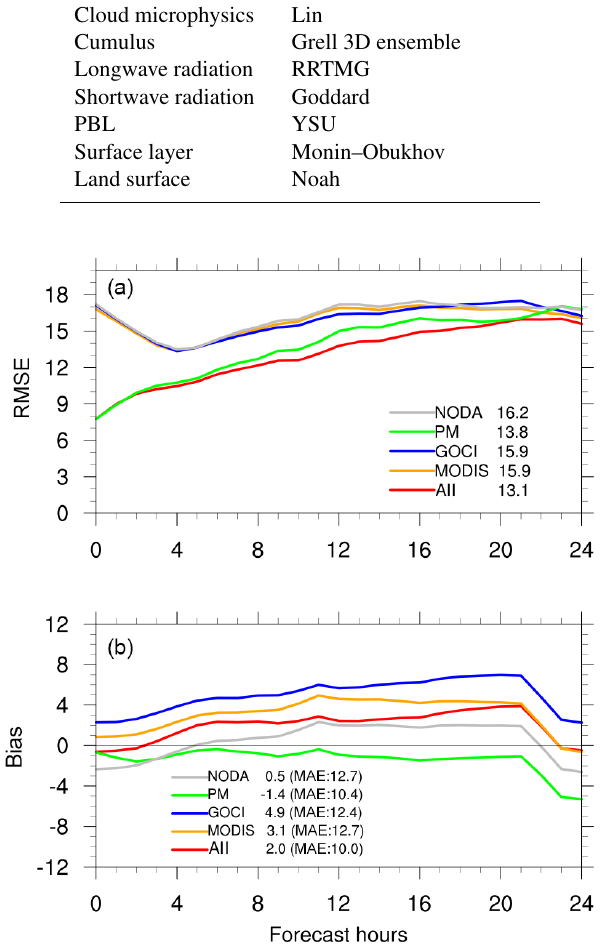
Figure 10. Time series of root mean square error (RMSE; a ) and bias (b) of the hourly forecasts from the 00:00UTC initialization for 4–31 May 2016. Different experiments in domain 2 are veri- fied against surface PM 2 . 5 observations from 361 stations in South Korea. An average of 0–24h forecast errors is shown next to each experiment name. The mean absolute error (MAE) over the 24h forecasts is also shown in panel (b) .